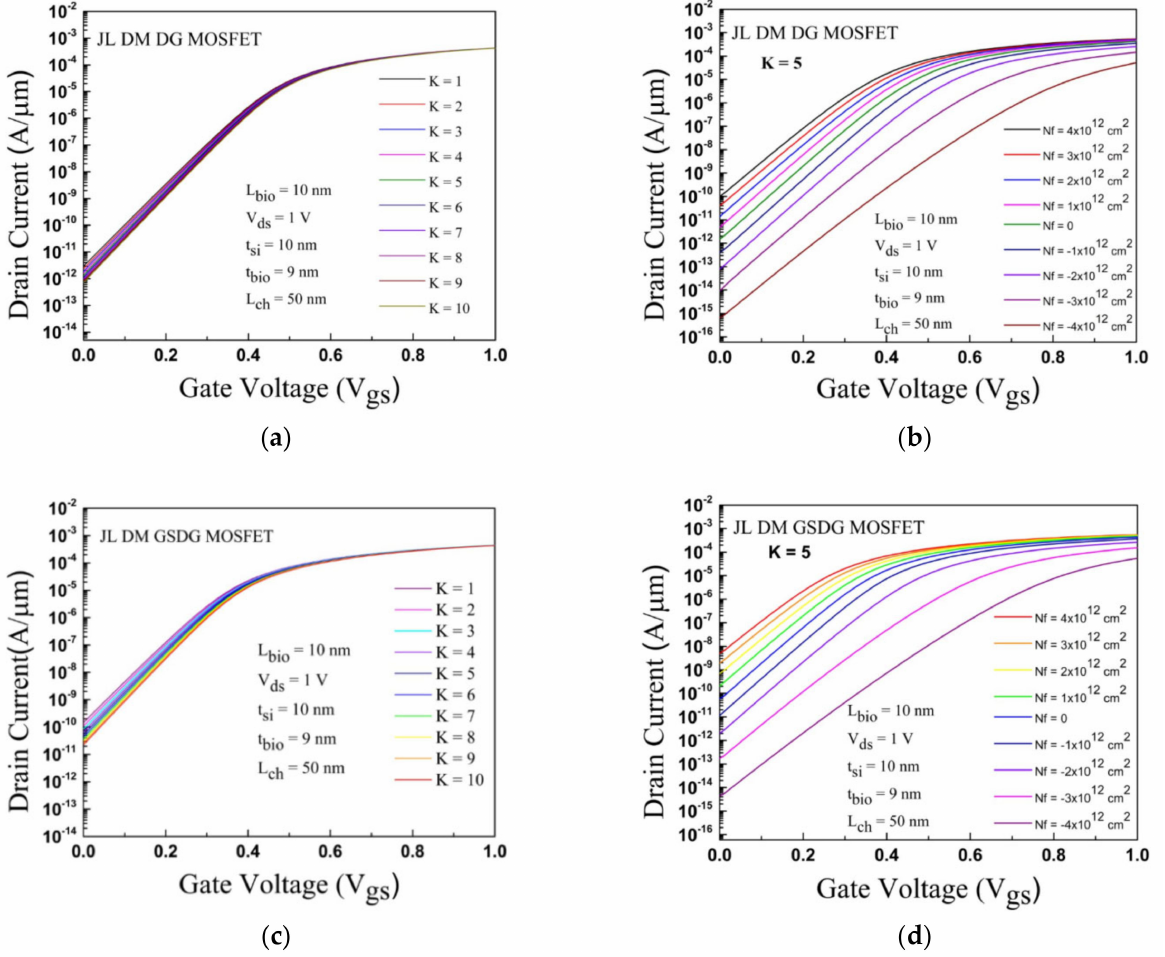
Figure 8. Plot of the transfer characteristics with V gs for JL-DM-DG-MOSFET and JL-DM-GSDG- MOSFET: ( a , c ) neutral biomolecules; ( b , d ) charged